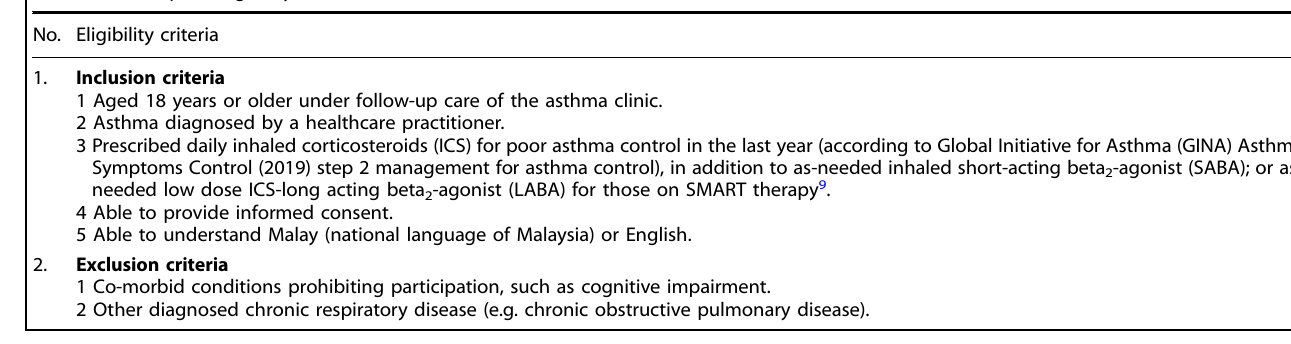
Table 1. Participant eligibility